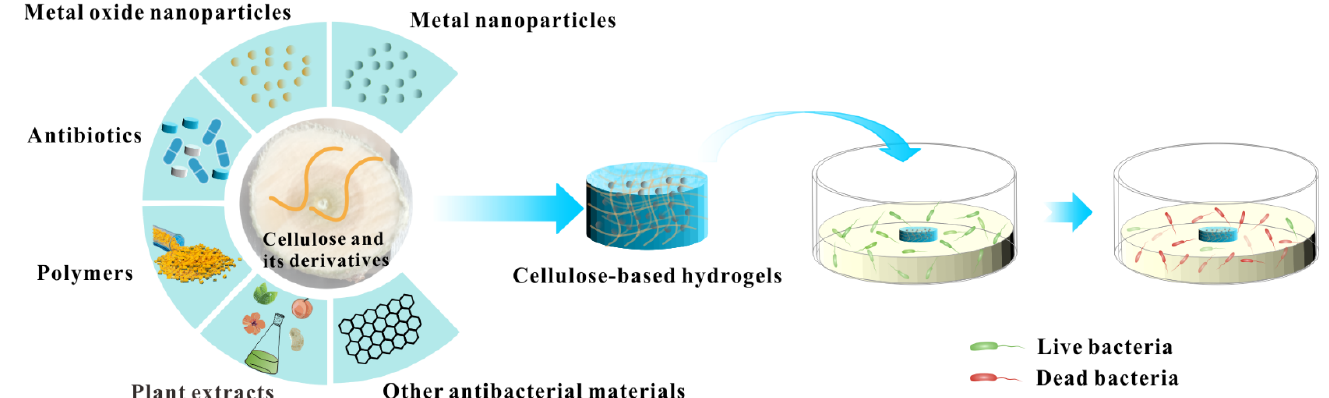
Figure 3. Antibacterial schematic diagram of cellulose-based hydrogels loaded with different antibacterial agents.